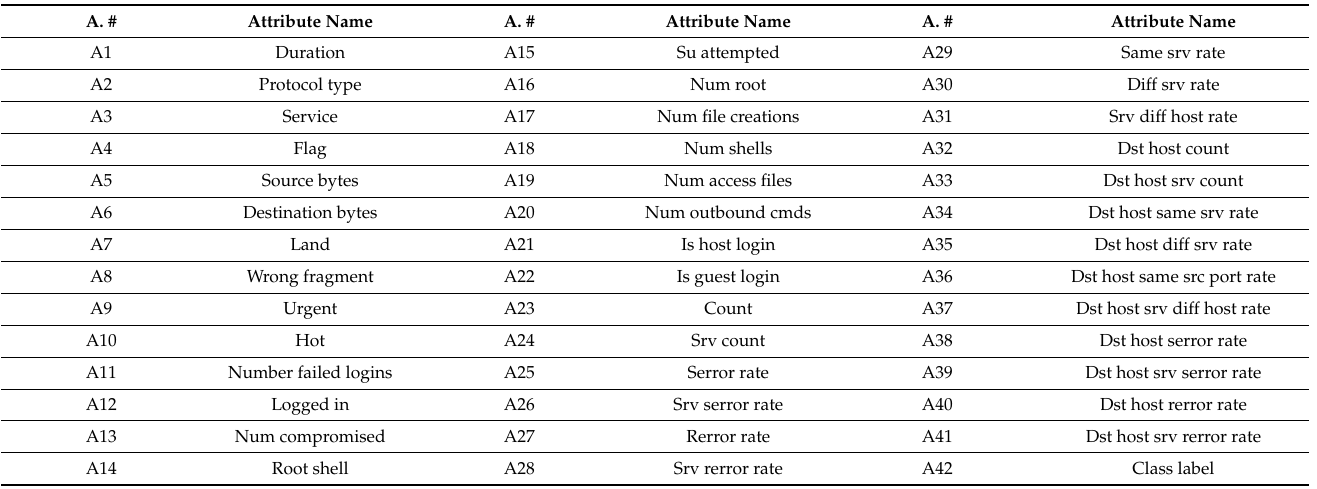
Table 5. NSL-KDD Attributes [21].